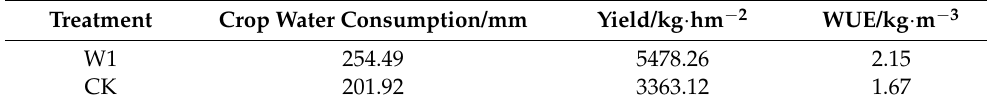
Table 2. Yield and water use efficiency of millet under different irrigation